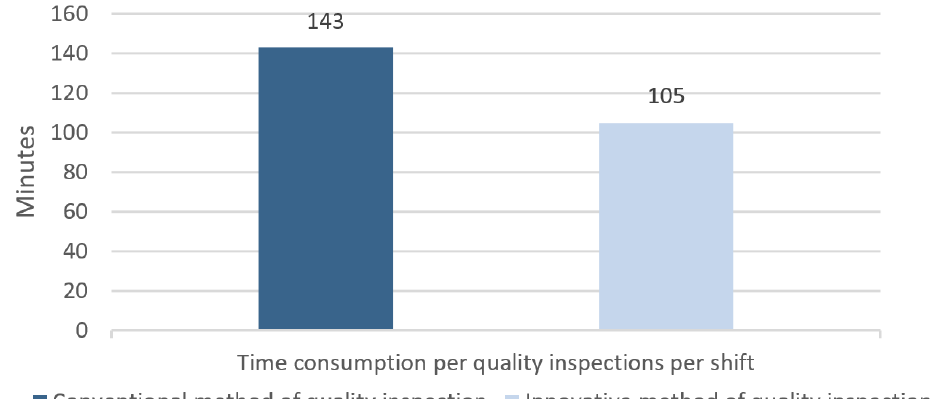
Figure 18. Comparison of an average strip surface quality inspection time over a 12-h shift before and after the introduction of a two-step quality control.